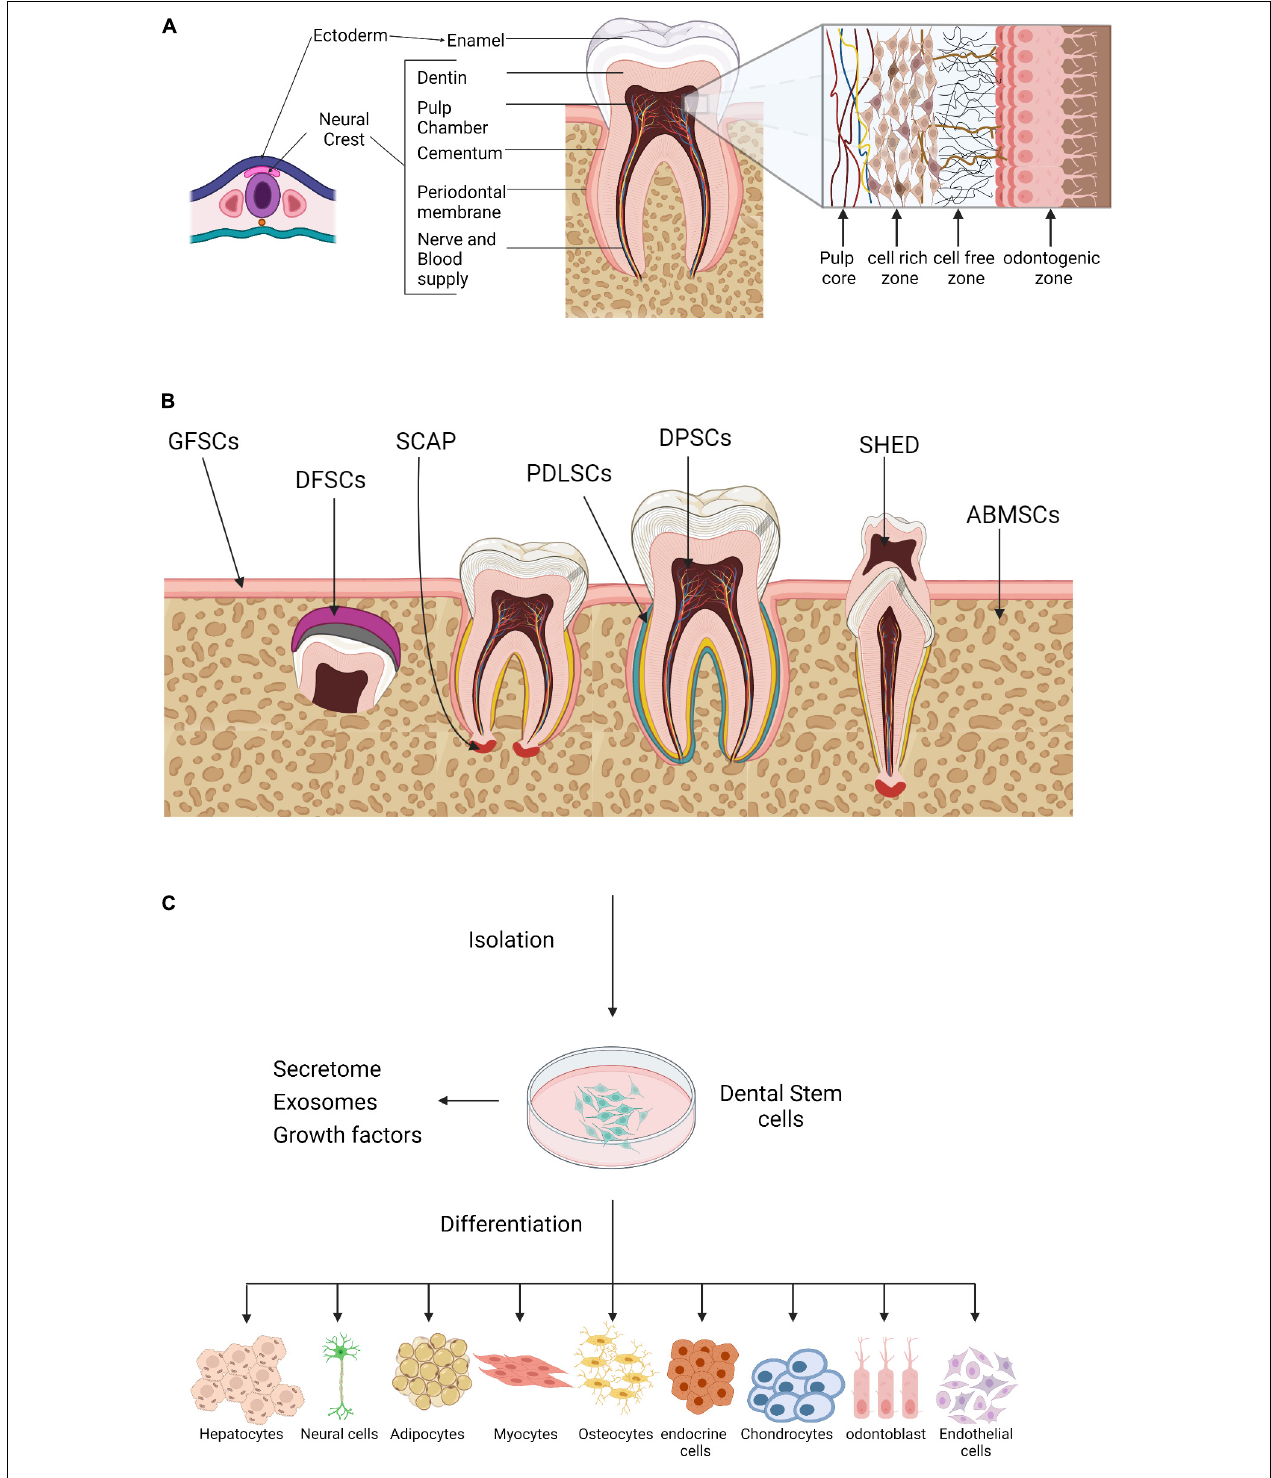
FIGURE 1 | Oral tissue and dental stem cells. (A) A schematic outline for the tooth development. Ectoderm cells contribute to the formation of the tooth enamel only, whereas, neural crest cells generate the rest of the tooth tissues. (B) Sources of oral tissue and dental stem cells. GMSCs, gingiva-derived mesenchymal stem cells; DFPCs, dental follicle precursor cells; SCAP, stem cells from apical papilla; PDLSCs, periodontal ligament stem cells; DPSCs, dental pulp stem cells; SHED, stem cells from human exfoliated deciduous teeth, ABMSCs, alveolar bone–derived mesenchymal stem cell. (C) A schematic illustration of the dental stem cells multilineage differentiation potential. Created with